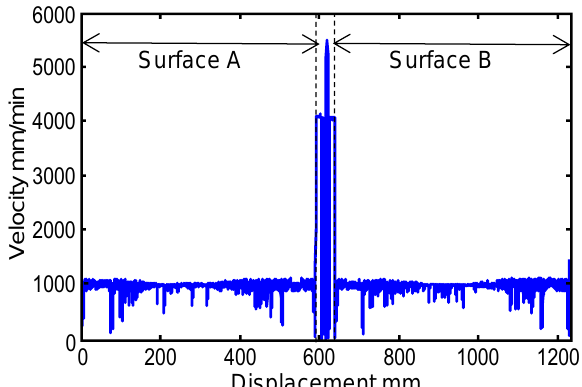
Figure 7. Tangential velocity along the path of tool motion during S-shaped machining; the velocity is calculated from the acquired feedback positions and angles.